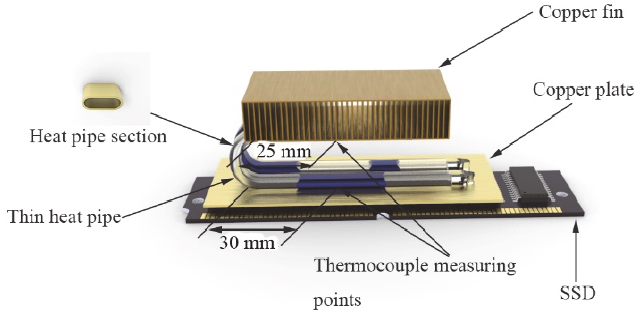
Figure 1. Schematic diagram of THP heat sink for cooling of SSDs. Table 1. Dimensional details of the THPs.